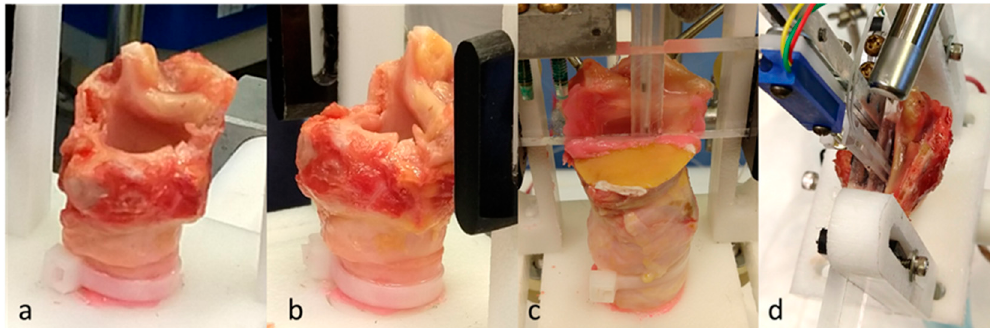
Figure 4. Hemilarynx preparation: ( a , b ) right laryngeal structures removed and left vocal fold and arytenoid preserved; ( c ) view of medial surface with transparent Lucite acrylic window acting as contacting surface for the left vocal fold (dental alginate affixed to seal air leaks), ( d ) view of superior surface with dovetailed slider for calibrated vertical positioning of pressure sensors.